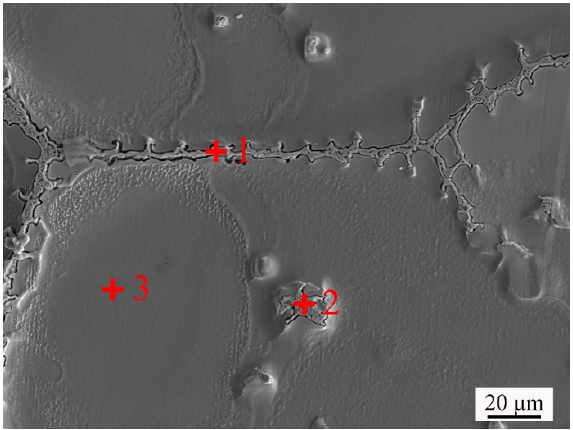
Figure 9. SEM image of GH3536 billet soaked at 1360 °C for 120 min. Table 1. EDS results of different locations marked in Figure 9.